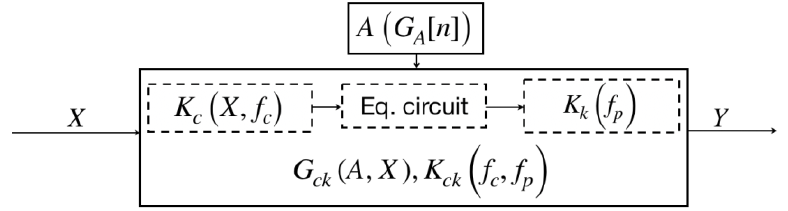
Figure 10. Next step of the simplification based on assumption of using learning techniques by analyzing experimental data.